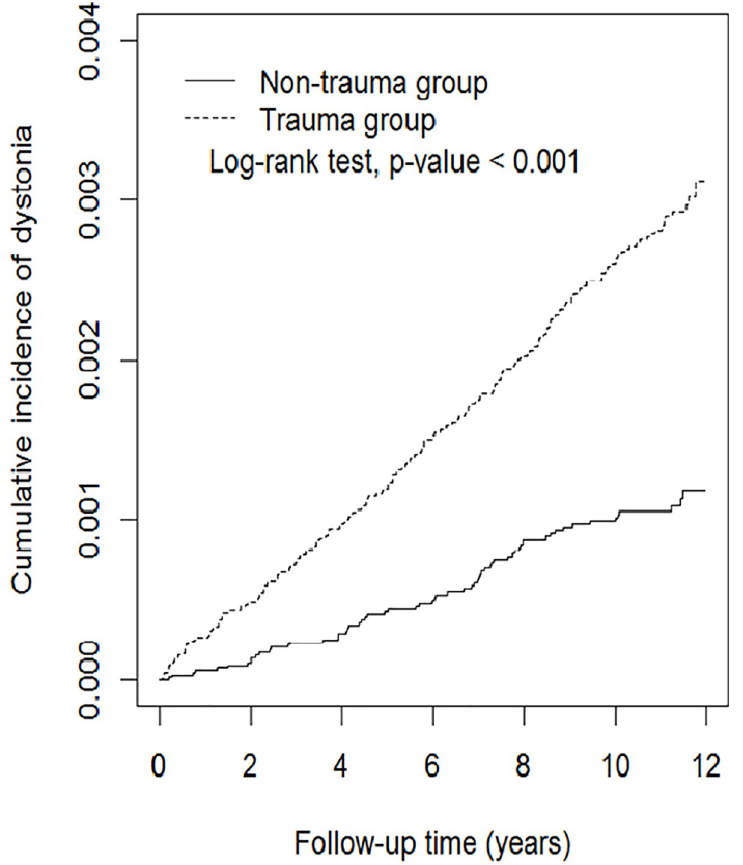
Fig 1. Cumulative incidence curves of dystonia for groups with and without